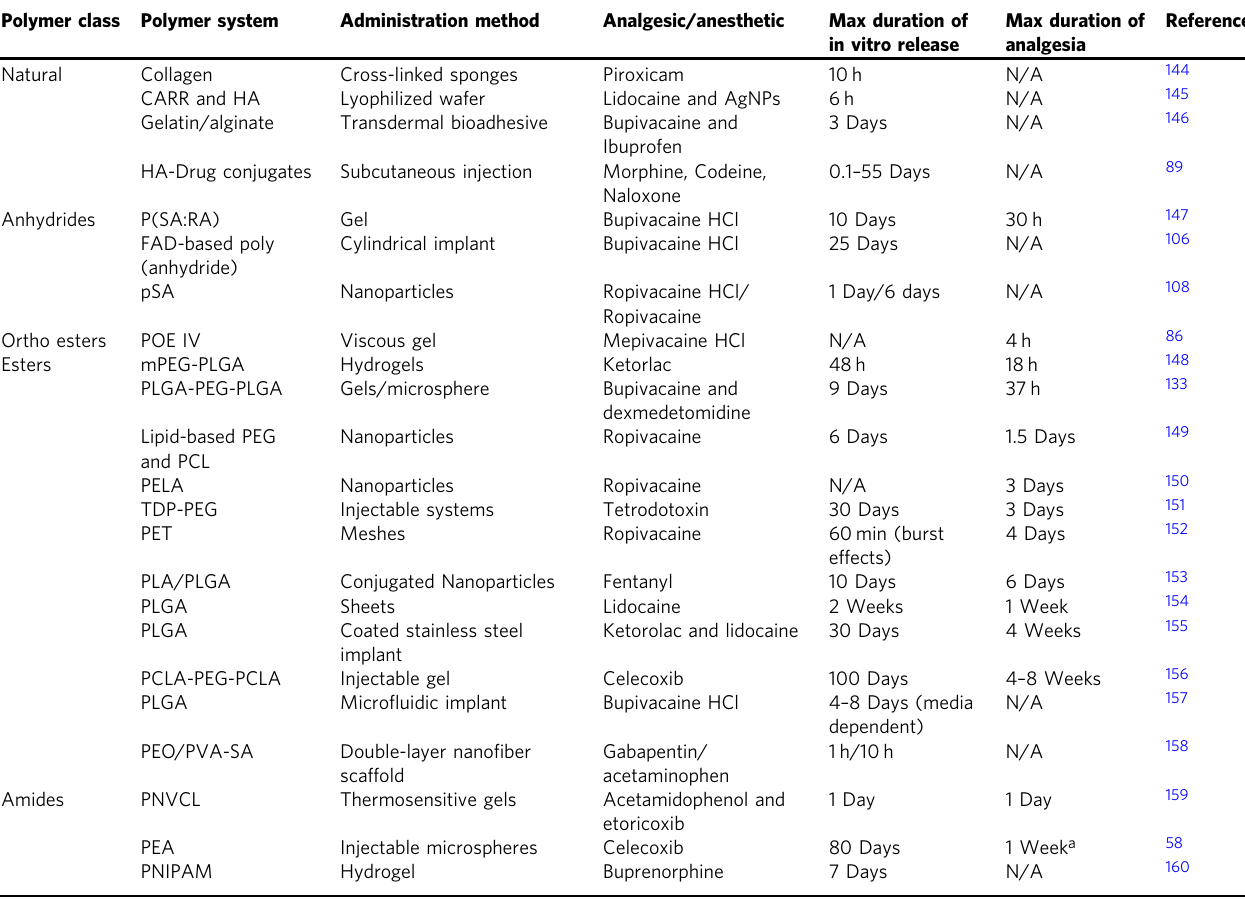
Table 1 Polymeric controlled drug delivery devices organized by polymer class, duration of in vitro release, then duration of analgesia exhibited in vivo, if